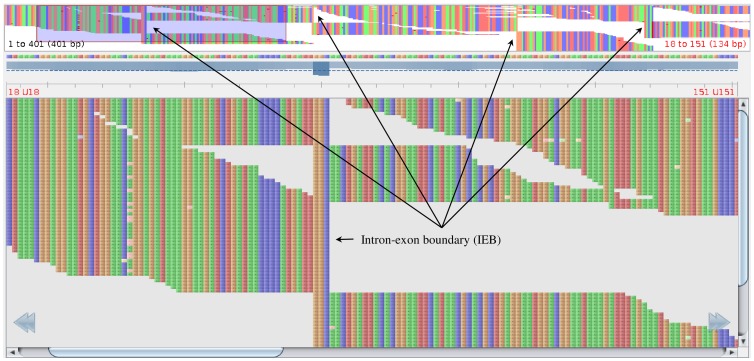
Output from the Tablet alignment visualizer [34] showing a G2T alignment for which 4 IEBs (arrows) have been detected (upper part of the display).The bottom part of the display focuses on the magnified area around the first IEB alignment pattern. See Materials and Methods for further explanation.